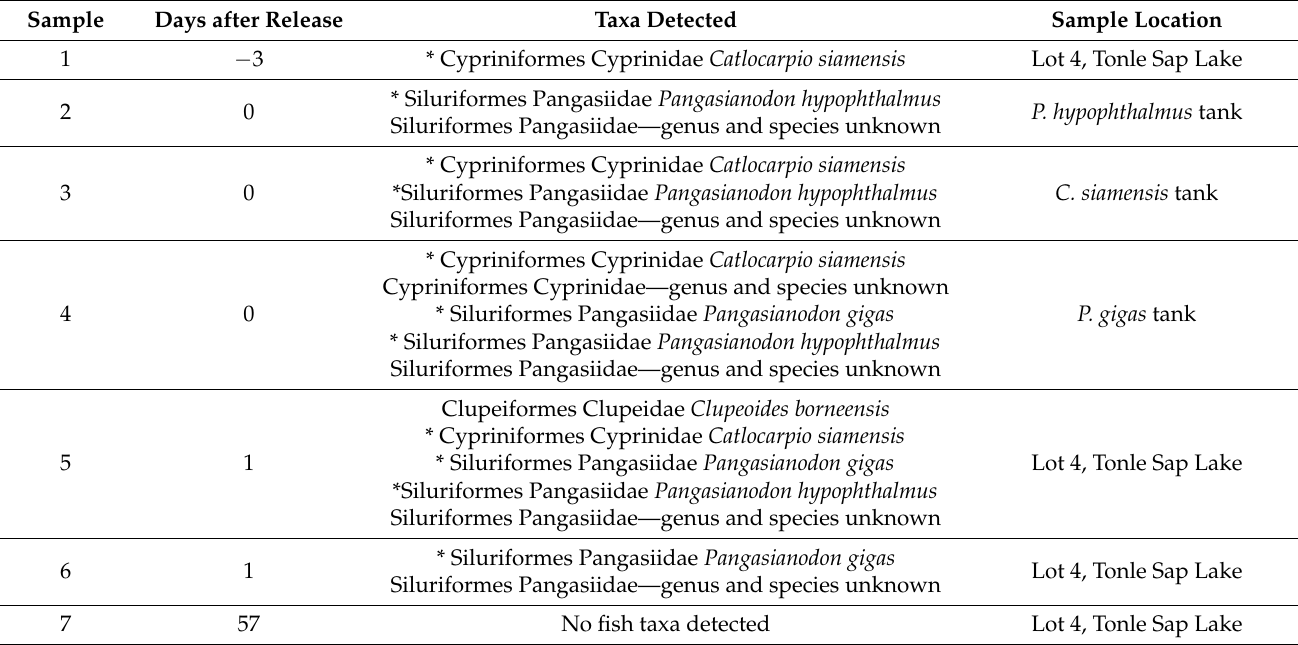
Table 4. The taxa detected in each of the seven eDNA